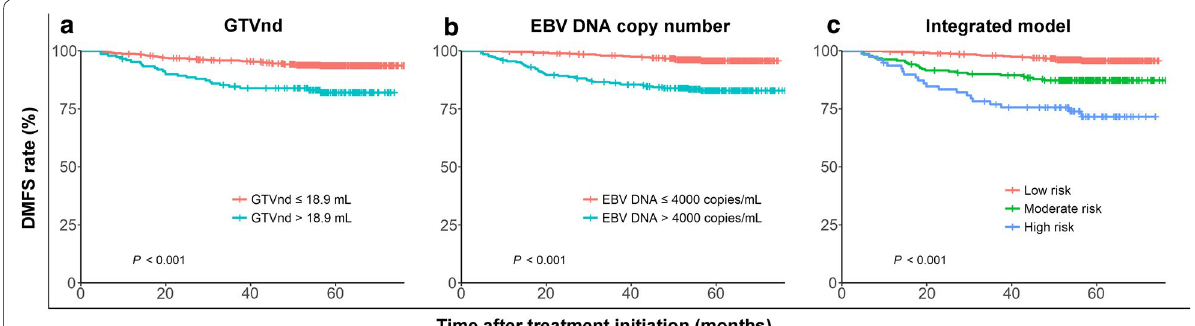
4000 copies/mL regardless ≤